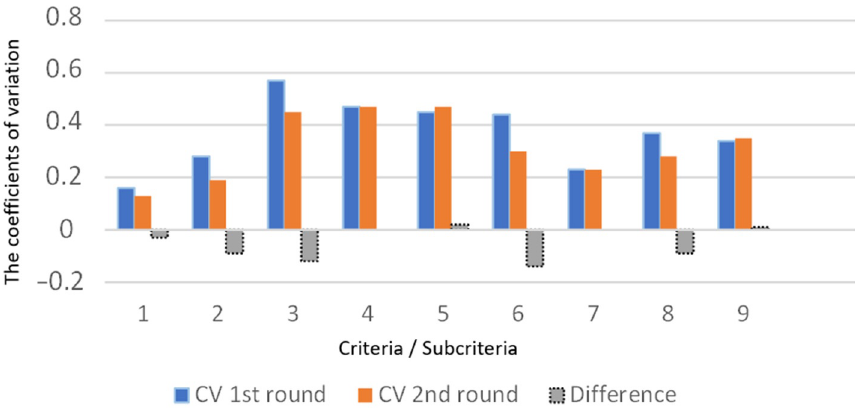
Figure 3. The coefficients of variation for the criteria and sub-criteria (Table 13 items 1 to 9) over the first and second rounds of consultation.